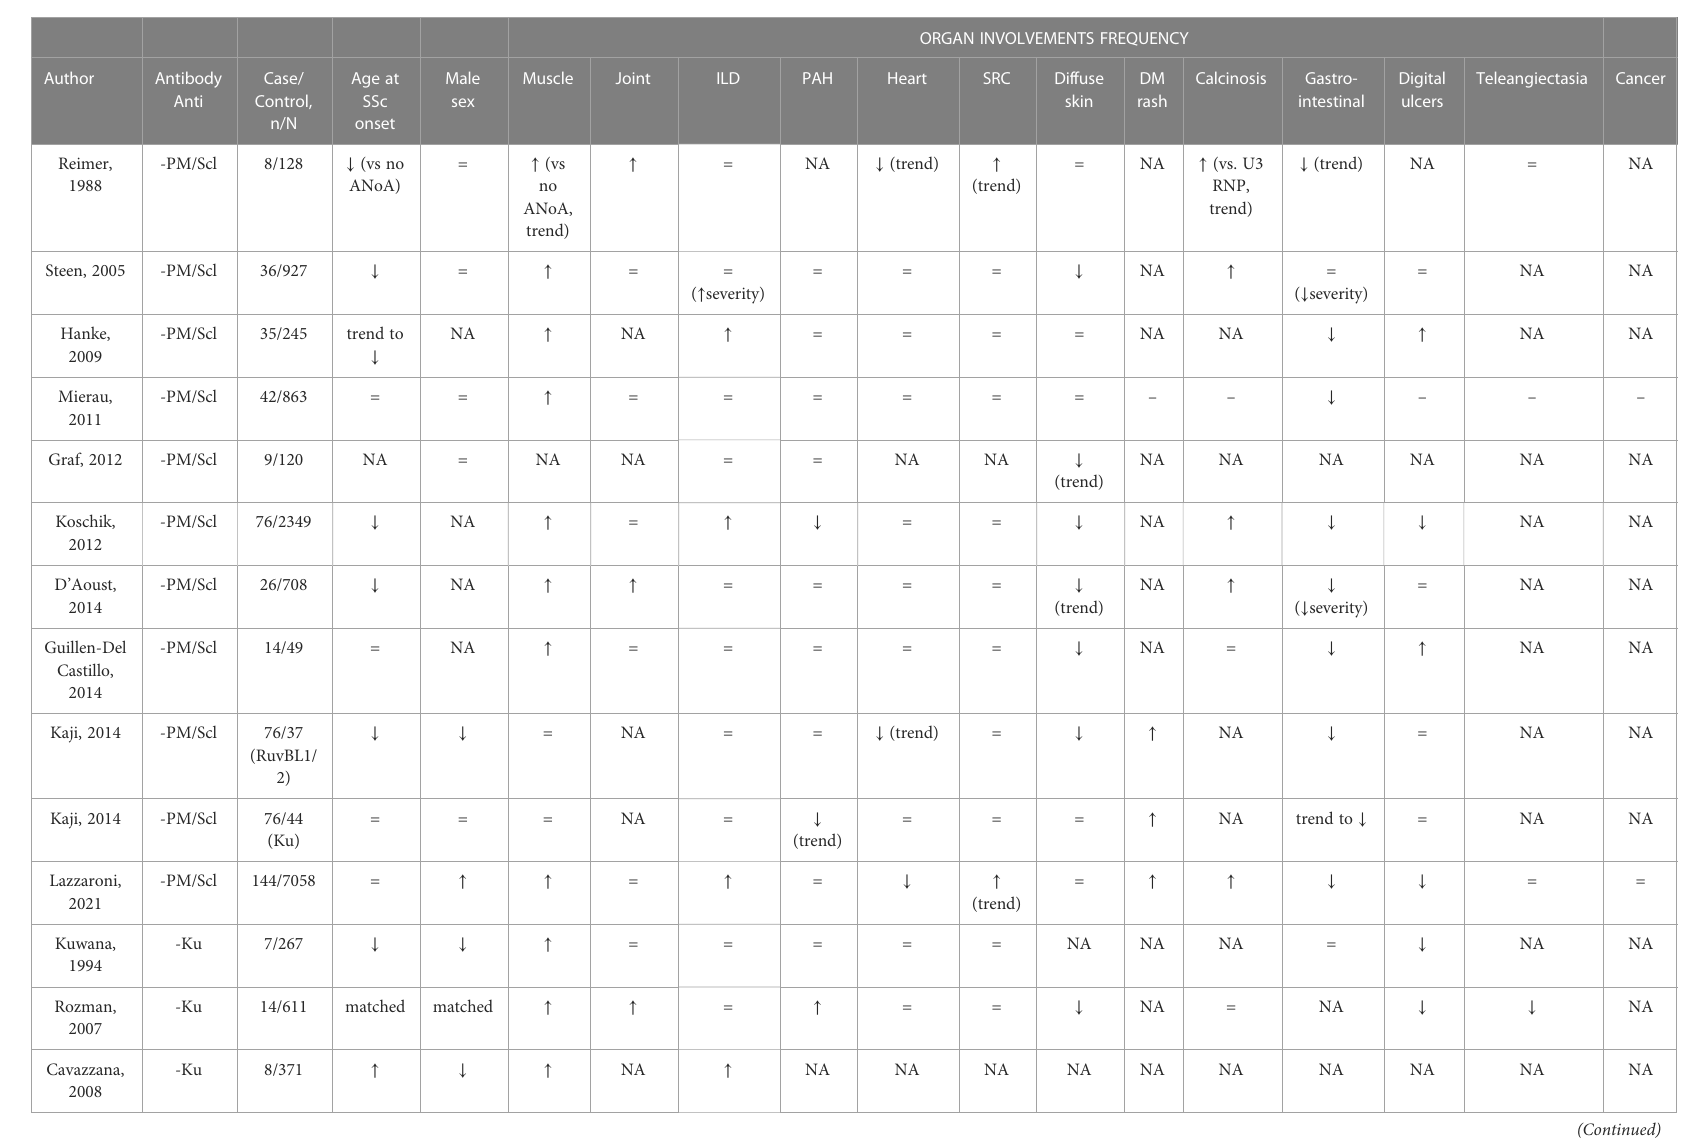
TABLE 4 Syndromes delineated by autoantibodies associated with